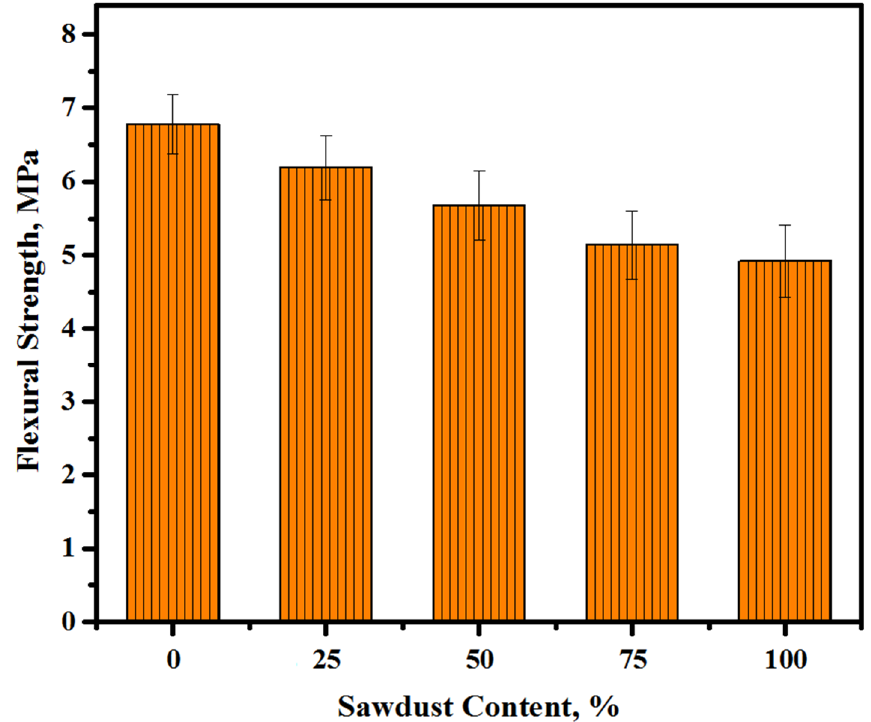
Figure 10. The FS of the prepared LWCs containing various amounts of sawdust.